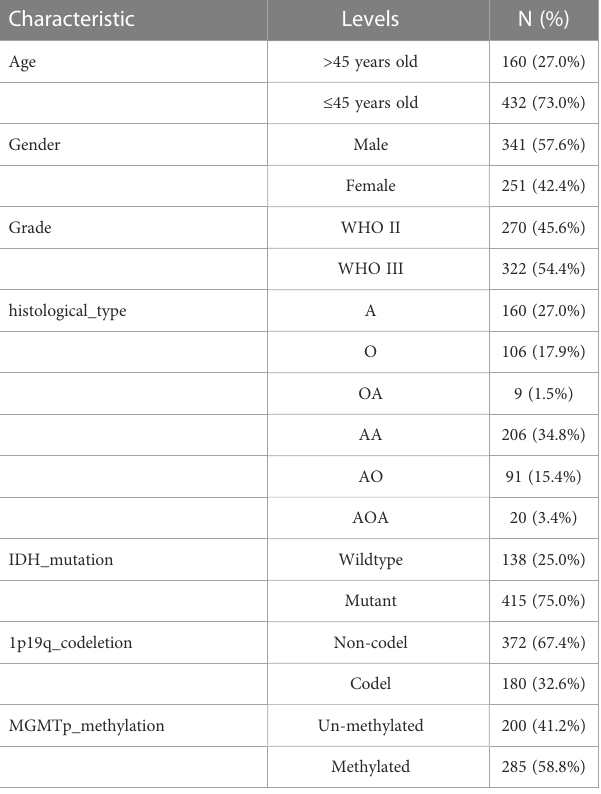
TABLE 2 Baseline Data Sheet for the Cohort of CGGA-LGG.